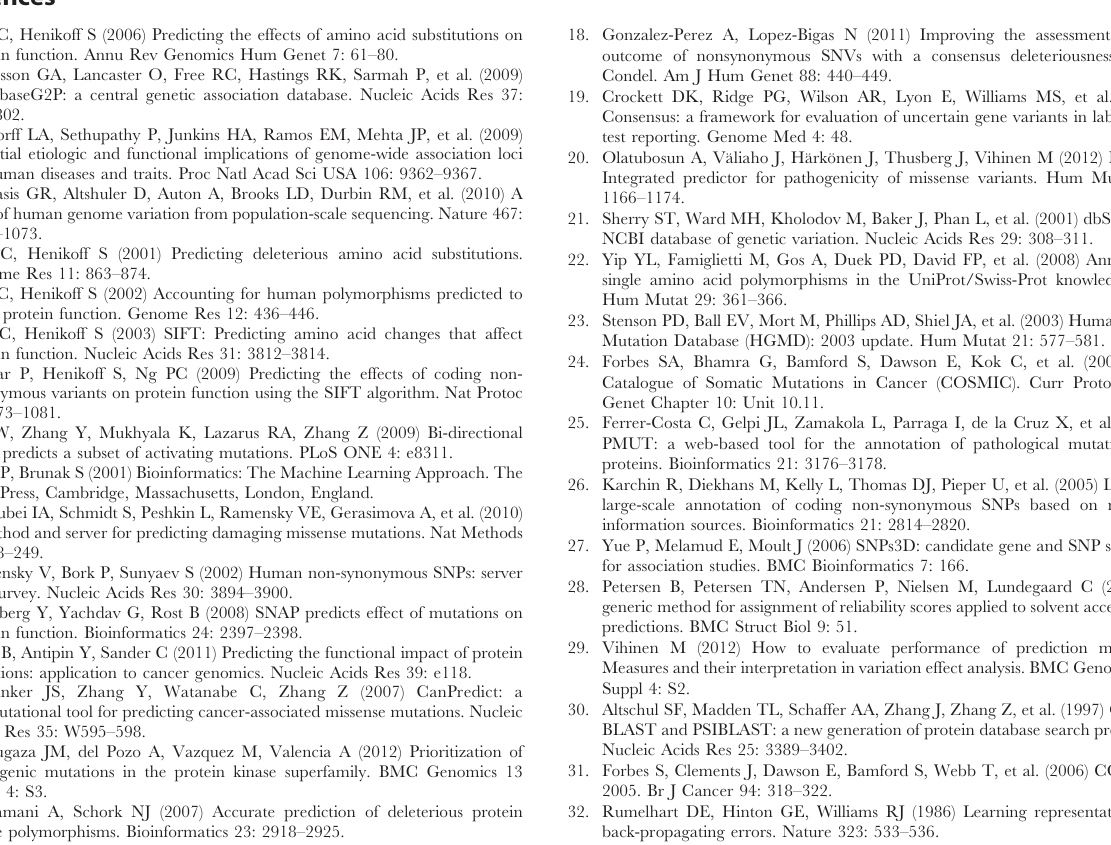
Table S2b Predictions by NetDiseaseSNP on mutations where NetDiseaseSNP predicts the mutation to be a disease